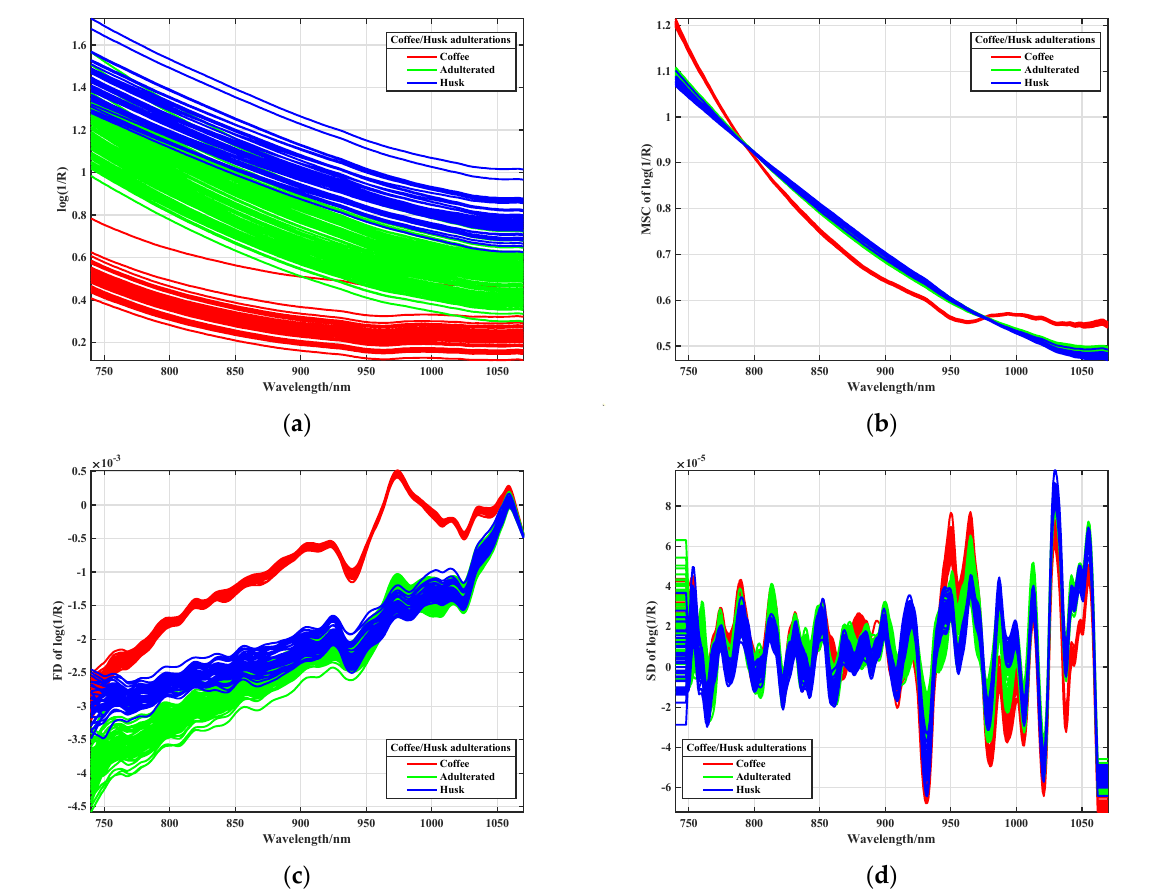
Figure 1. Raw spectral profile of Robusta coffee and adulterants: ( a ) raw, ( b ) MSC, ( c ) FD and ( d ) SD.